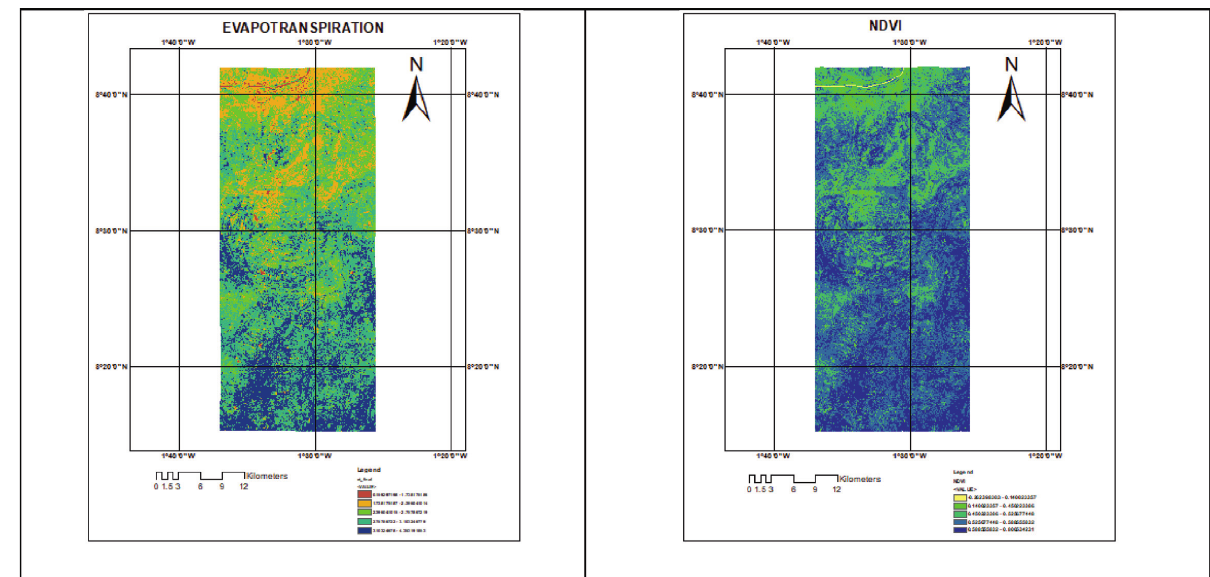
Figure 3: Evapotranspiration and normalized difference vegetation index map for 11/11/2015. 00.20.40.60.811.21.41.61.82 Figure 4: Scatter plot of ET against NDVI in February.